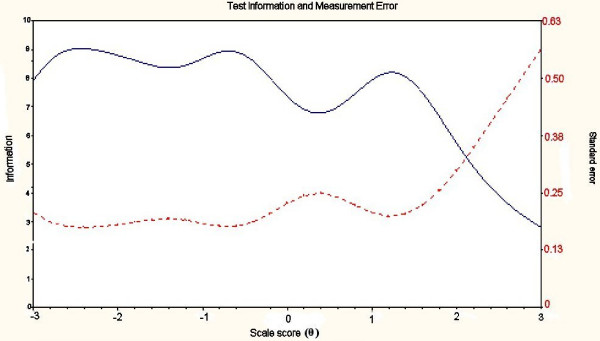
Total information across the construct for Ab-I.Test information curve - solid line; Standard error curve - dotted line.